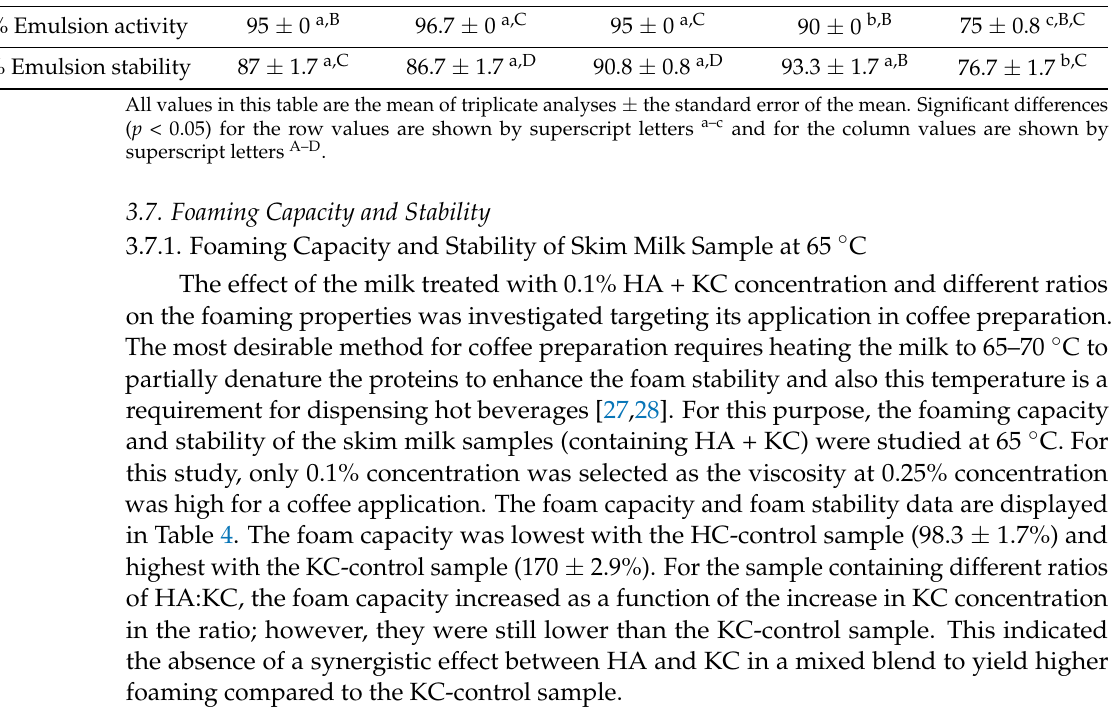
Table 4. Foaming capacity and stability of the skim milk sample at 65 ◦ C treated with 0.1% HA + KC concentration and different ratios of HA + KC